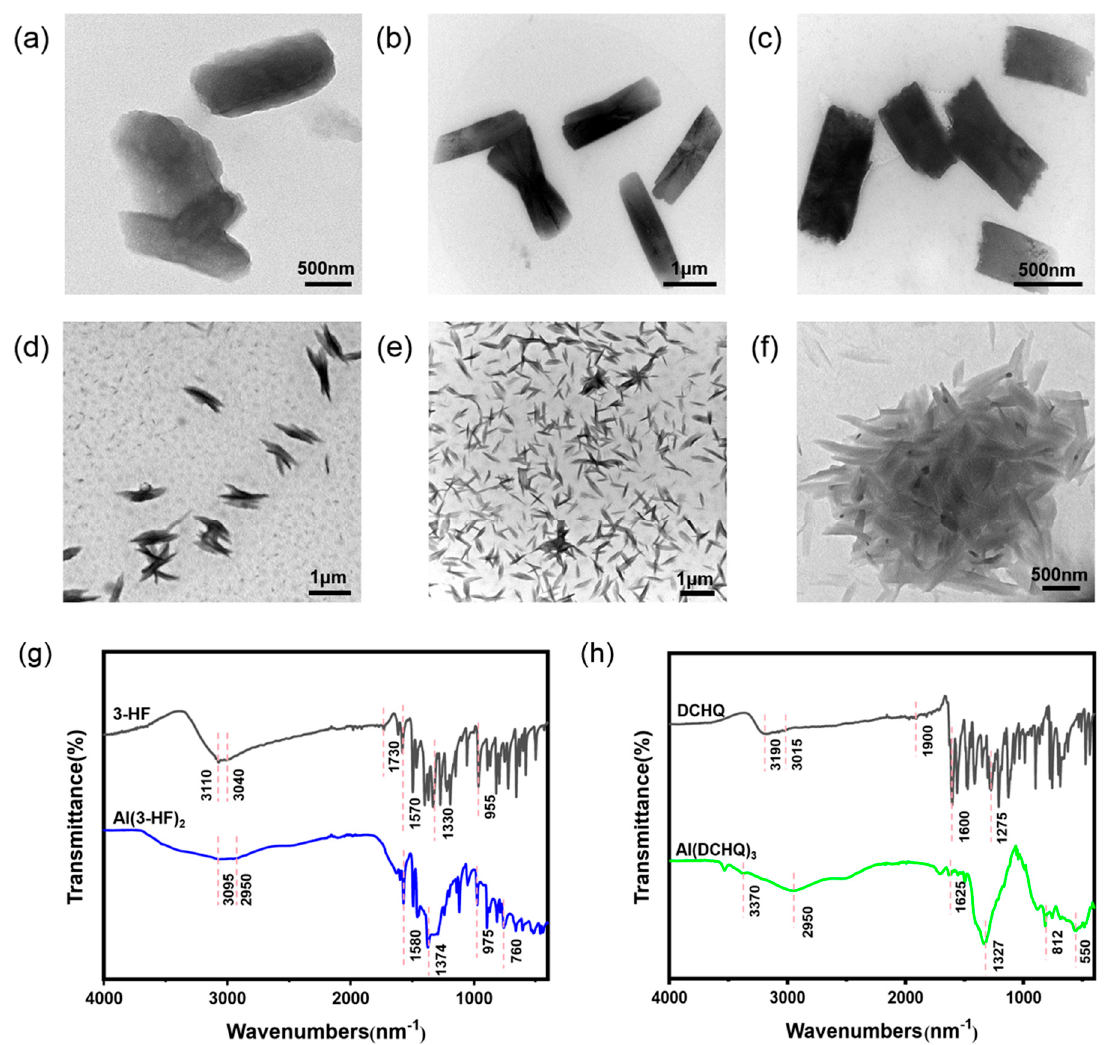
Figure 2. TEM images of different concentrations of ( a − c ) Al(3-HF) 2 ; the concentrations of aluminum (III) ions are ( a ) 0.0005 M, ( b ) 0.0010 M, and ( c ) 0.0020 M. TEM images of different concentrations of ( d − f ) Al(DCHQ) 3 ; the concentrations of aluminum (III) ions are ( d ) 0.0005 M, ( e ) 0.0010 M, and ( f ) 0.0020 M. FT-IR spectra of ( g ) 3-HF and Al(3-HF) 2 and of ( h ) DCHQ and Al(DCHQ) 3 .